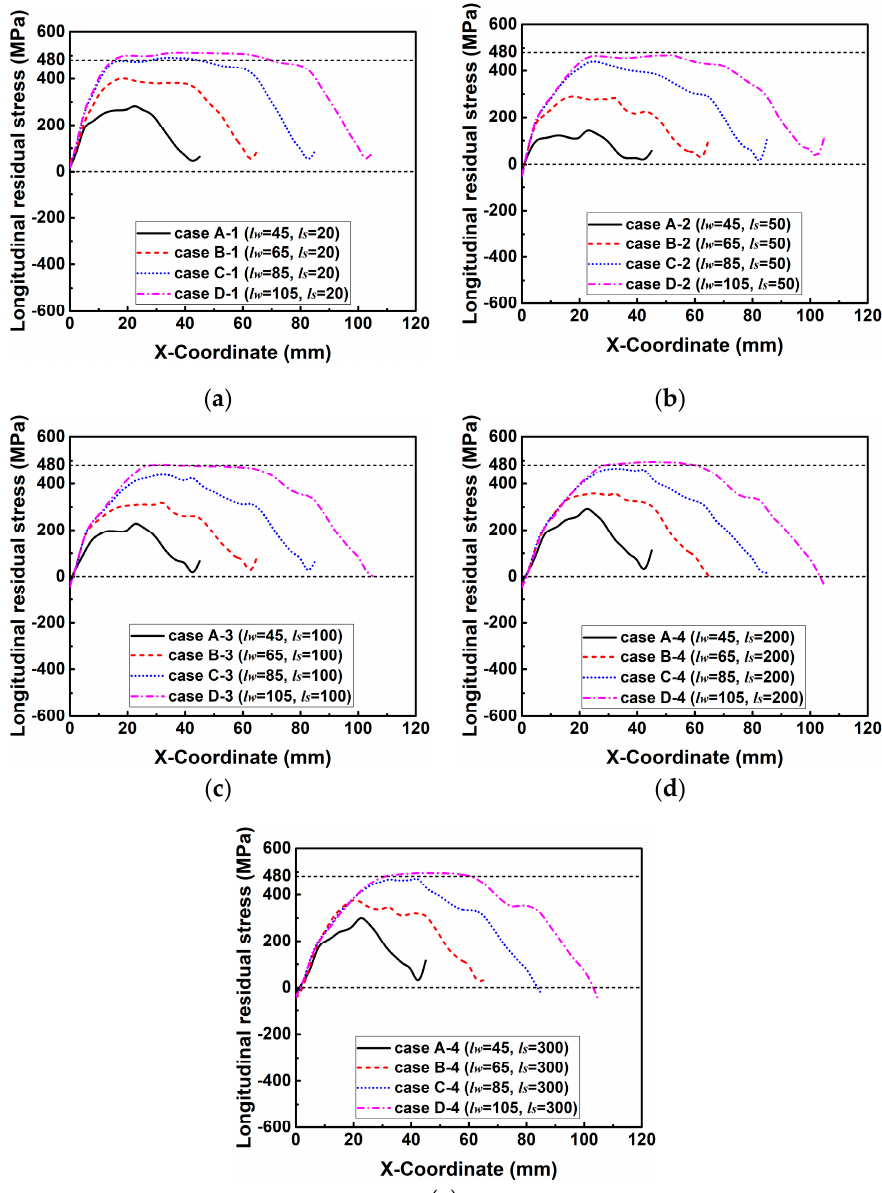
Figure 20. Longitudinal residual stress distributions along line 2 in the cases of each group with varied weld length ( l w ) while the slit length ( l s ) is kept constant: ( a ) Group 1; ( b ) group 2; ( c ) group 3; ( d ) group 4; ( e ) group 5.